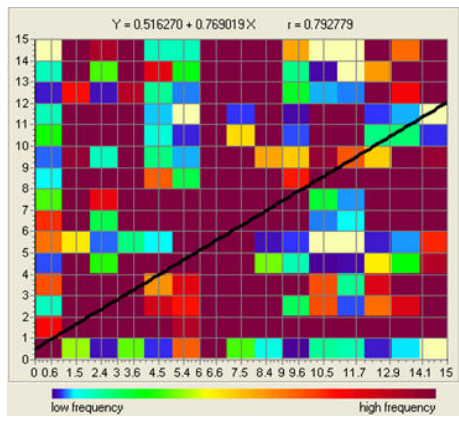
Figure 12. Spatial relationship between predicted LULC of 2007 (using 7x7 contiguity filter) and LULC derived from LISS III image of 2007 (references image)